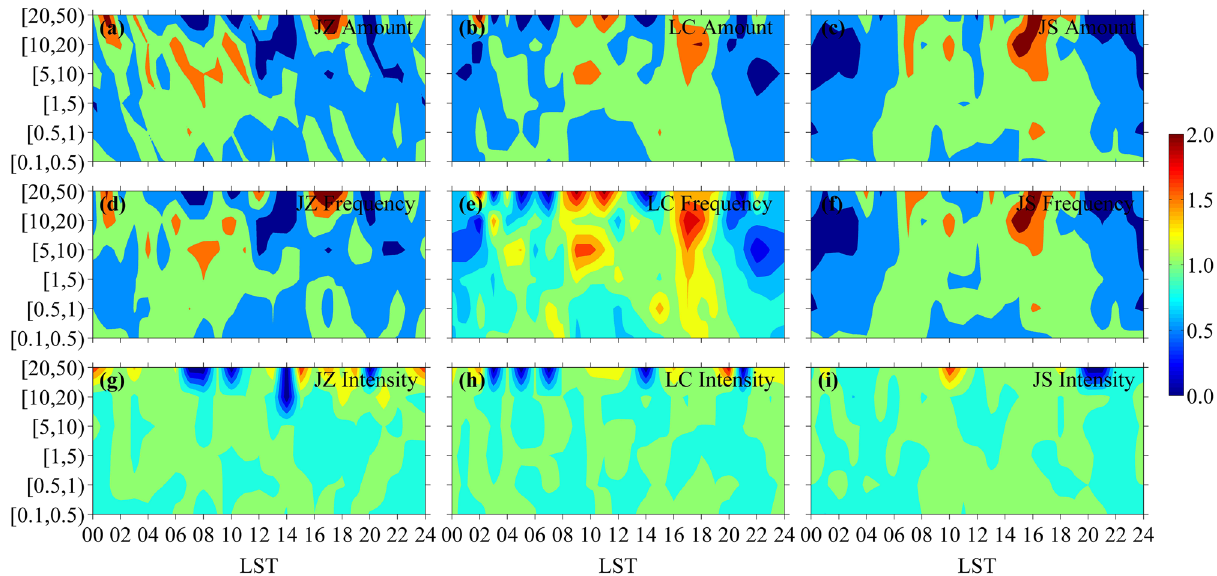
Figure 9. Diurnal variations of precipitation ( a – c ) amount, ( d – f ) frequency and ( g – i ) intensity with dimensionless processing obtained from summer hourly precipitation data of JZ (left), LC (middle) and JS (right) stations during